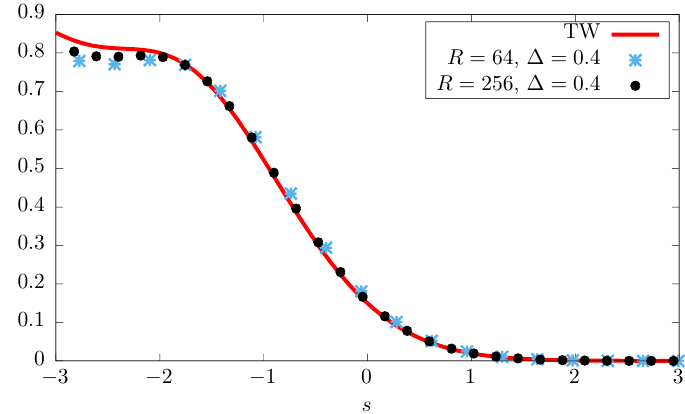
Figure 5: Rescaled entanglement entropy close to the right edge, which is expected to converge to (38) in the limit R → ∞